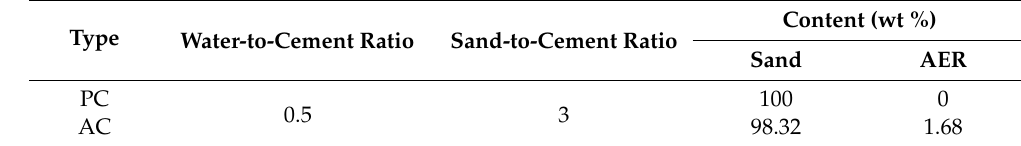
Table 5. Mix proportions of cement mortar.